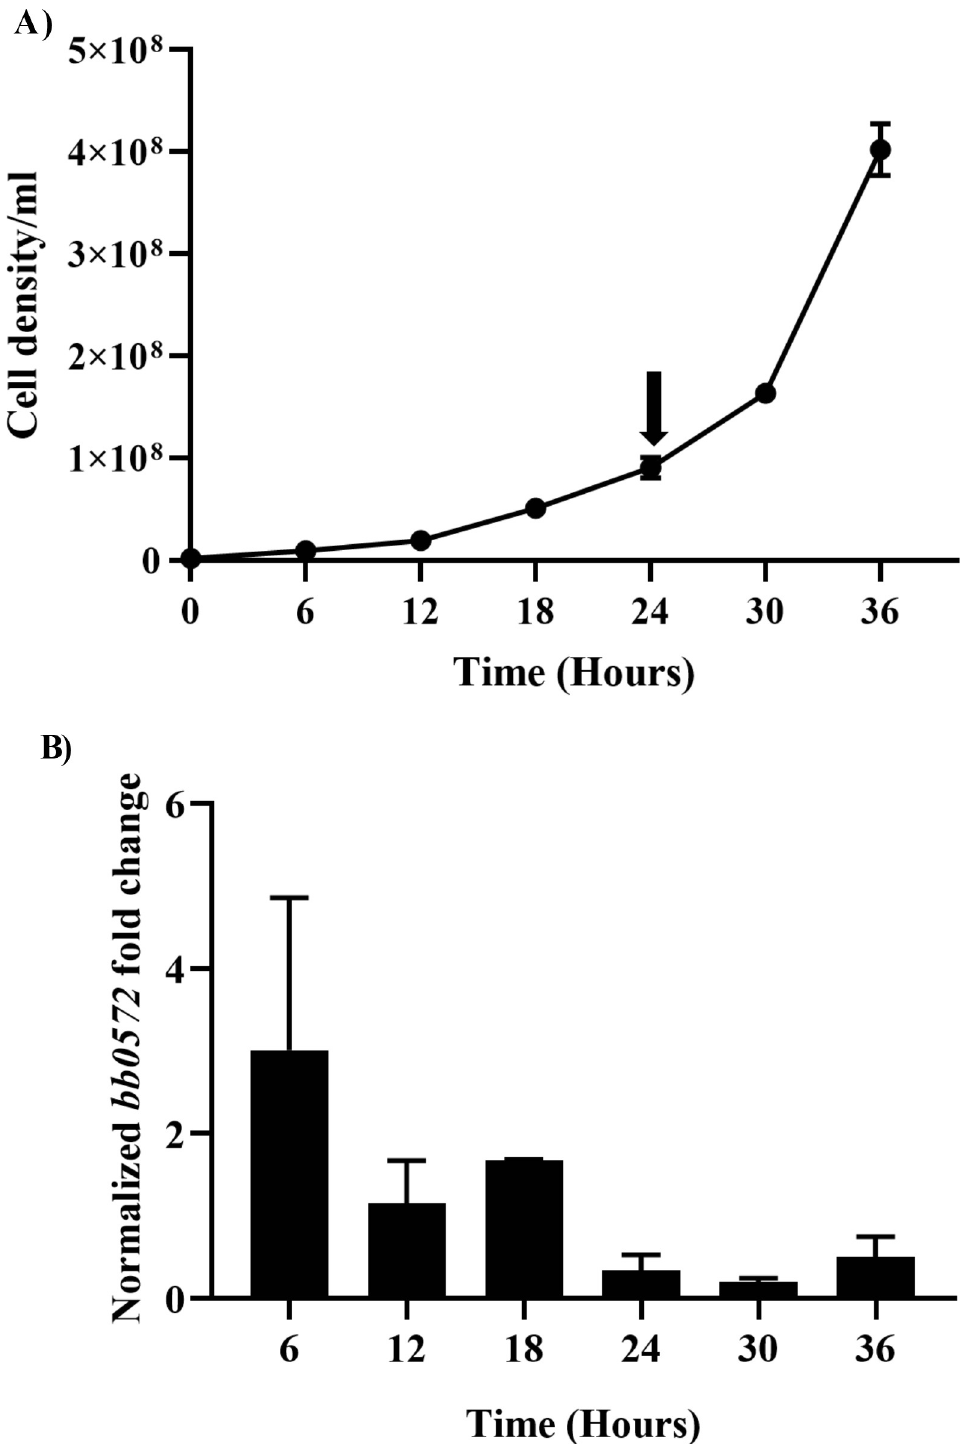
Fig 4. Cell density and kinetics of bb0572 expression in Borrelia burgdorferi cultured in vitro . Bb cells at early exponential phase (1x10 6 ) were cultured and harvested at 6, 12, 18, 24, 30 and 36 h to determine expression of bb0572 . A . Cell densities were monitored by dark-field microscopy every six hours, corresponding to cell harvest for RNA extraction for expression analysis. B . Gene expression of bb0572 was normalized with the flaB as the house keeping gene. Fold change represents change in expression of bb0572 between 6 to 36 h relative to time zero (baseline). No significant